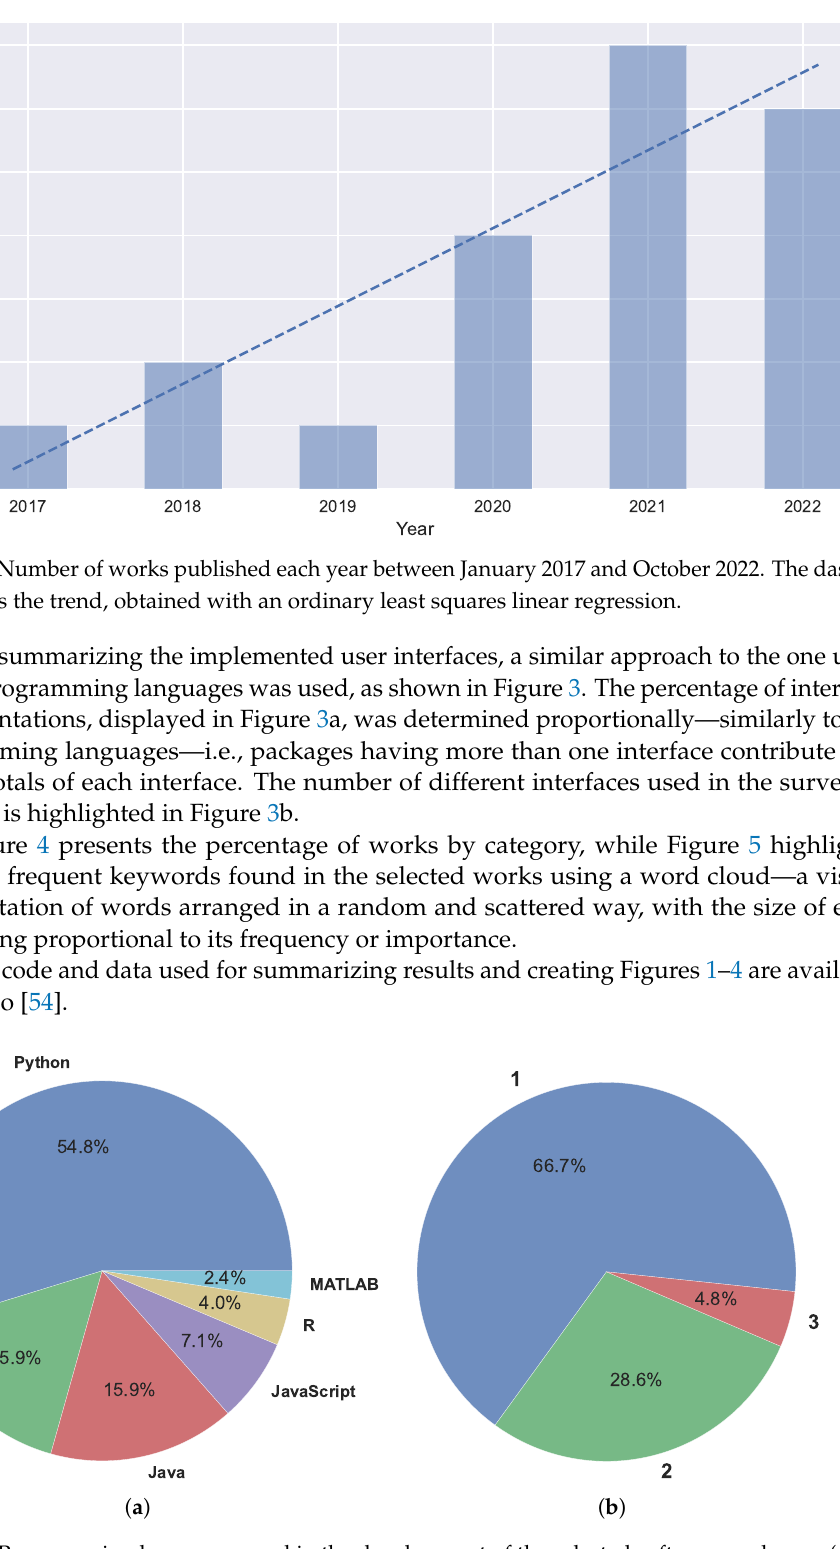
Figure 2. Programming languages used in the development of the selected software packages: ( a ) by percentage; and ( b ) by number of languages used for development of a single package. Regarding ( a